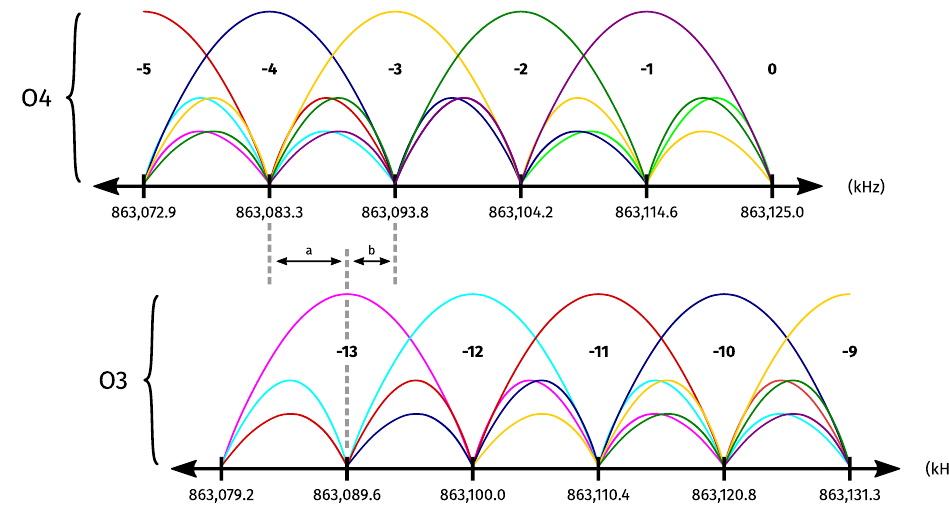
Figure 6. Frequency domain overlap between modulated sub-carriers of SUN-OFDM O4 and O3 PHYs. For example, O3 sub-carrier − 13 is spaced a = 6250 Hz from O4 sub-carrier − 4 and b ≈ 4167 Hz from O4 sub-carrier − 3.